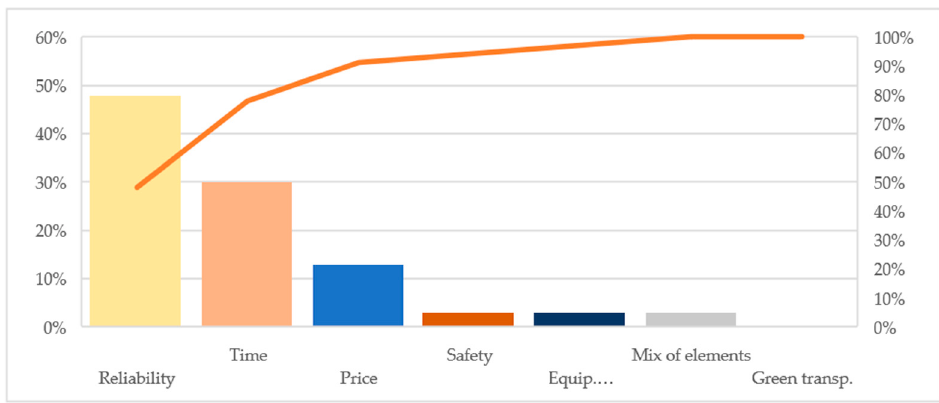
Figure 4. Changes in port logistics during the COVID-19 pandemic.